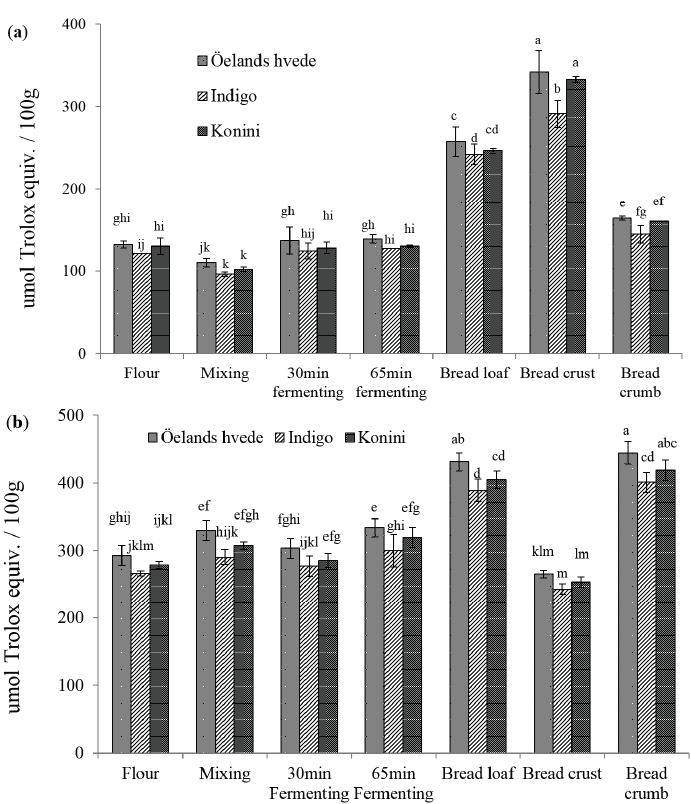
Figure 1. DPPH radical scavenging capacity of soluble ( a ) and insoluble ( b ) phenolic compounds. Columns marked by different letters are significantly different ( p <